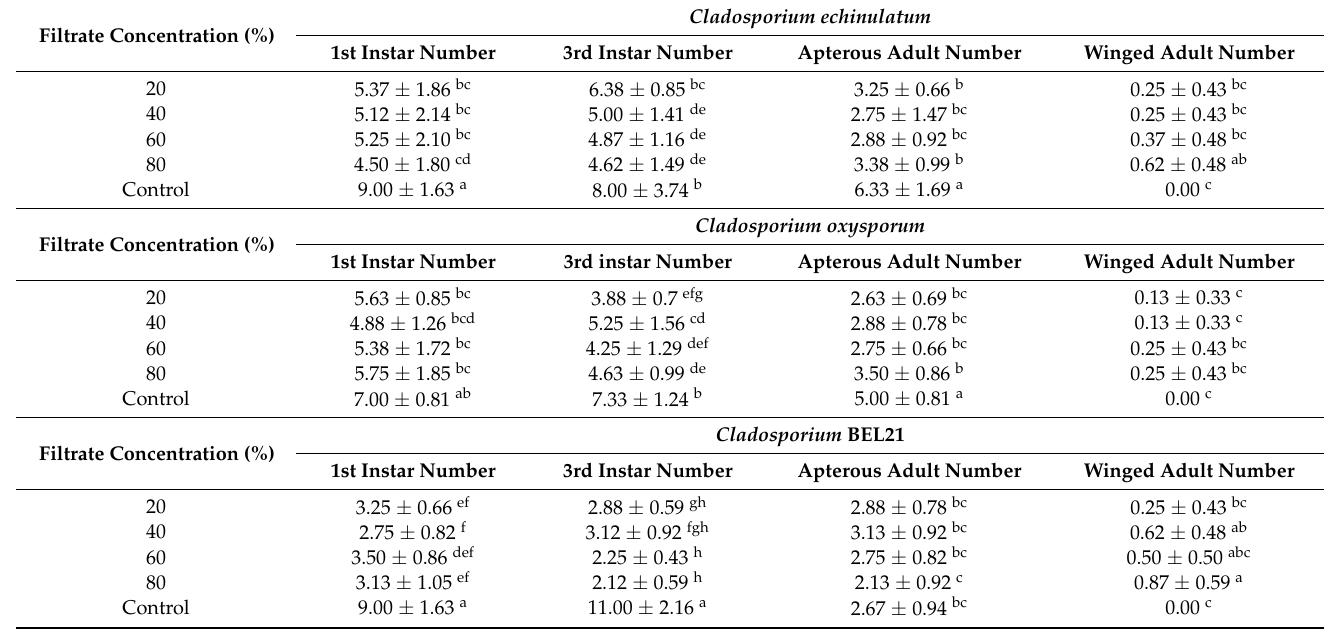
Table 2. Effect of potato pre-treatment by invert emulsions on demographic parameters of M. persicae .